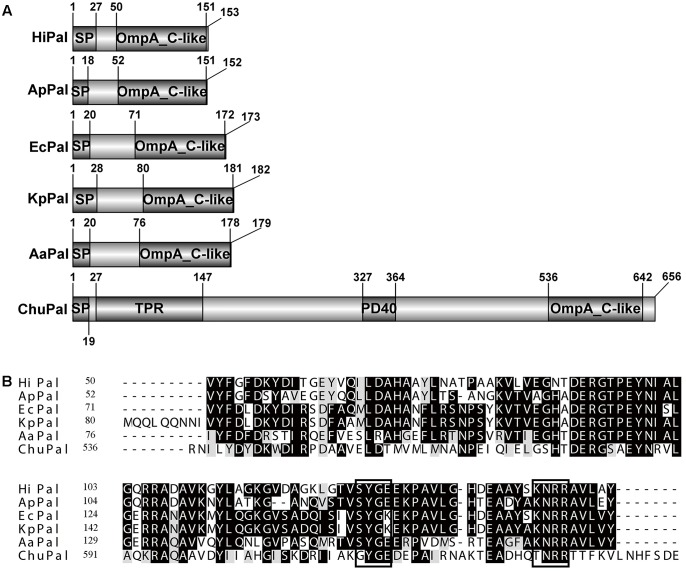
Sequence analysis of CHU_0125 (chuPal). (A) Schematic domain architecture of CHU_0125 and related Pals. SP, N-terminal signal peptide. (B) Sequence alignment of the OmpA_C-like domain of CHU_0125 and related Pals by CLUSTALW. Dark shading indicated identical amino acids and light shading indicated similar amino acids. Black rectangle box indicated conserved motif in Pals. Their GenBank accession numbers are: ChuPAL (Cytophaga hutchinsonii) (ABG57418), HiPAL (Haemophilus influenza) (NP_438542), ApPAL (Actinobacillus pleuropneumoniae) (EFL81759), EcPAL (Escherichia coli) (ZP_12055177), KpPal Klebsiella pneumoniae (CDO13556), AaPAL (Alkalomonas amylolytica) (AGO28205).